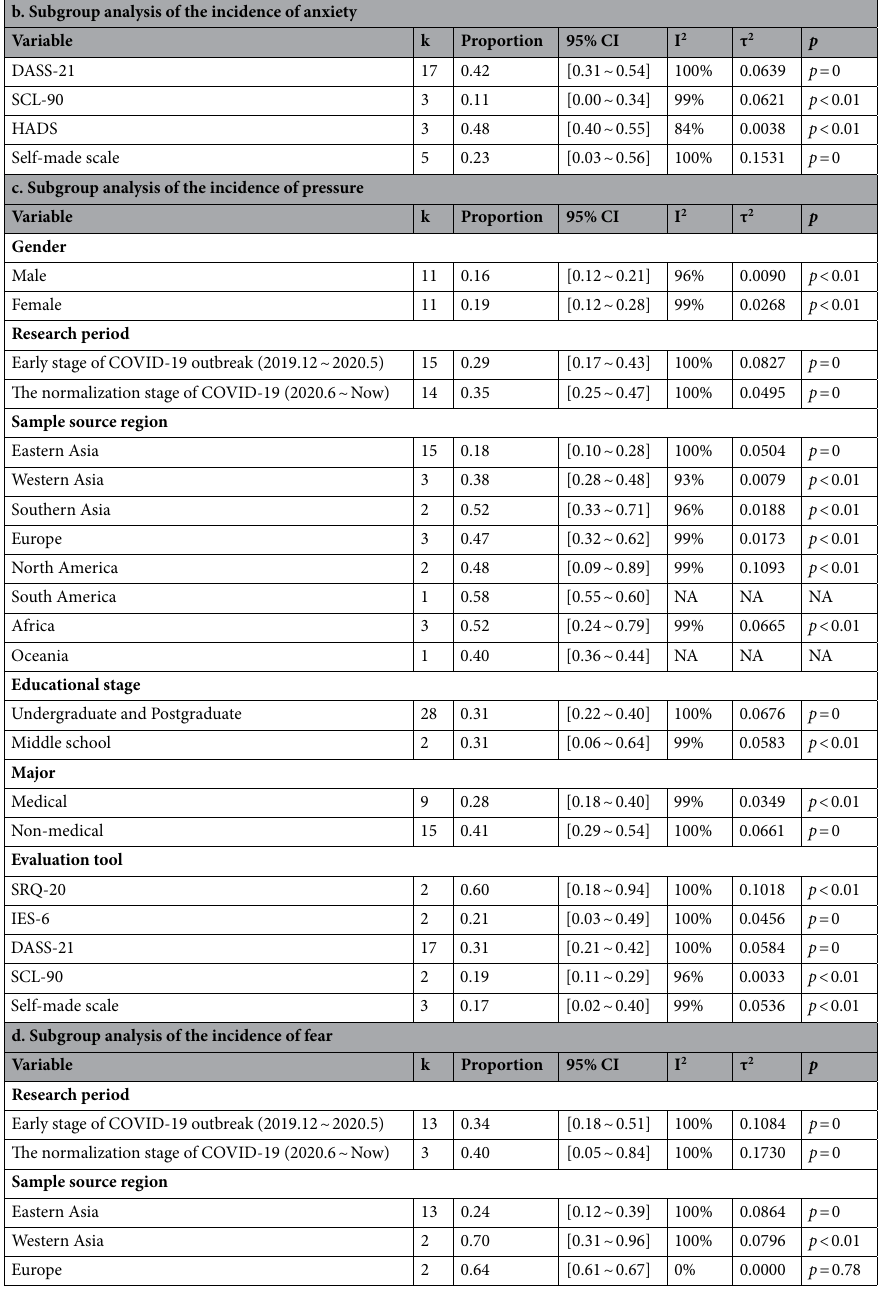
Table 3. Subgroup analysis of psychological stress responses in the student population during